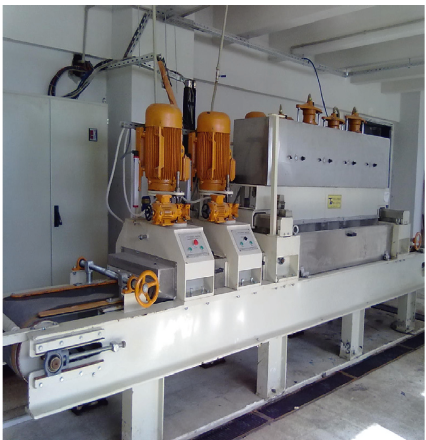
Figure 1: Laboratory-scaled polishing